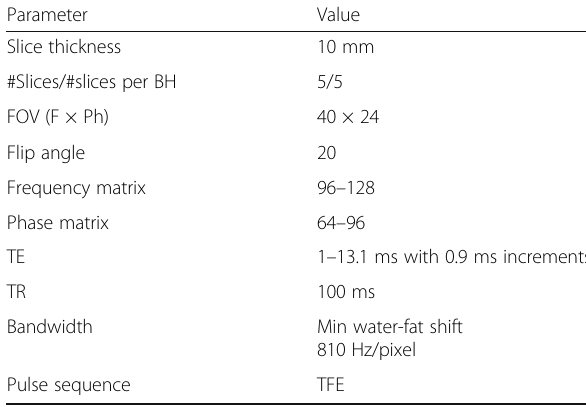
Table 2 Parameters for liver T2*